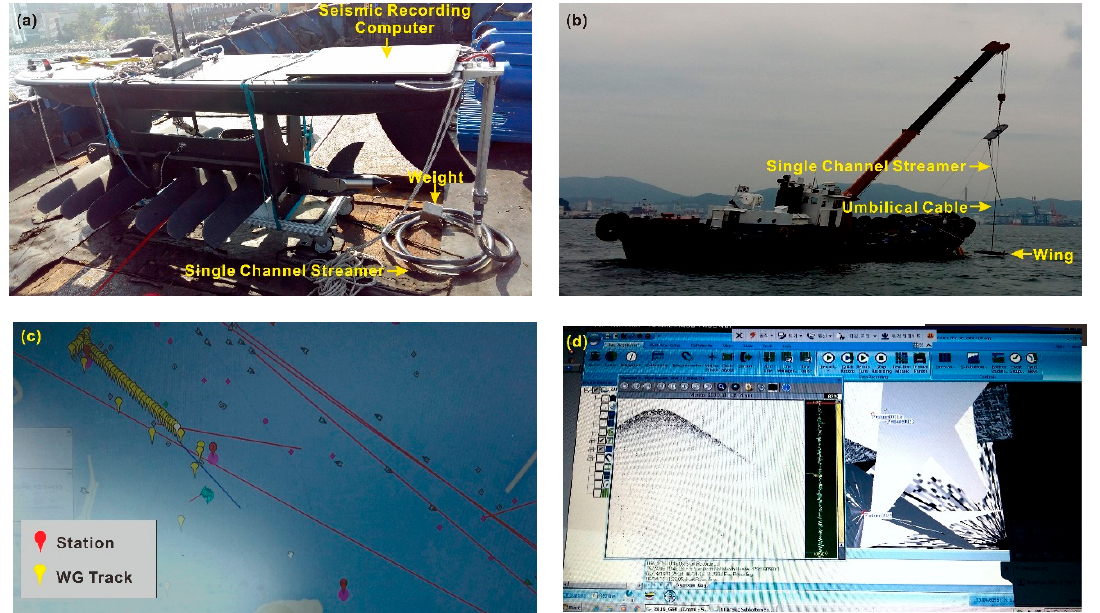
Figure 4. Photographs of ( a ) the wave glider (WG) equipped with a single-channel streamer, ( b ) the launch of the WG, ( c ) tracking and monitoring the position of the WG via the software manufacturer’s webpage, and ( d ) real-time quality-control monitoring of seismic data via a remote connection (modified from [24]).